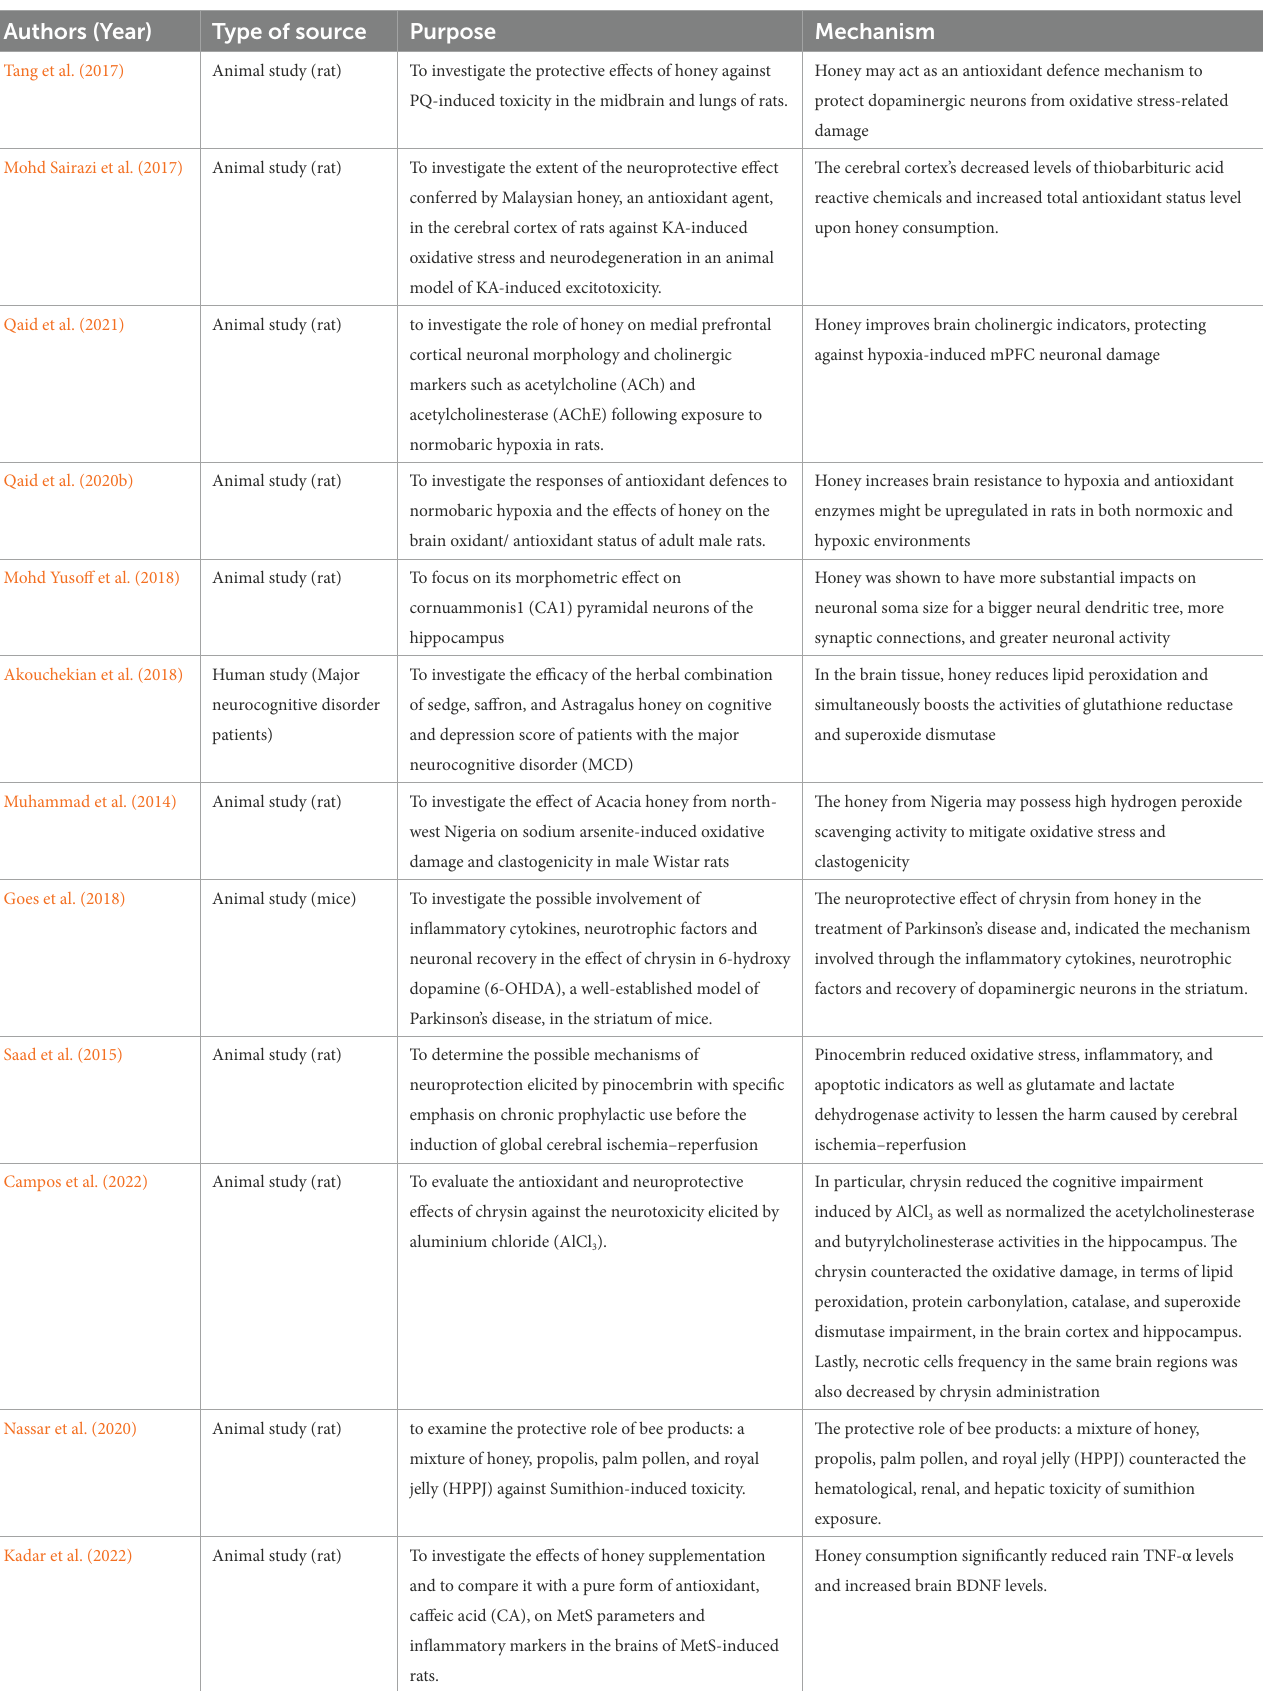
TABLE 3 Neuroprotective effects of honey supplementation on animal